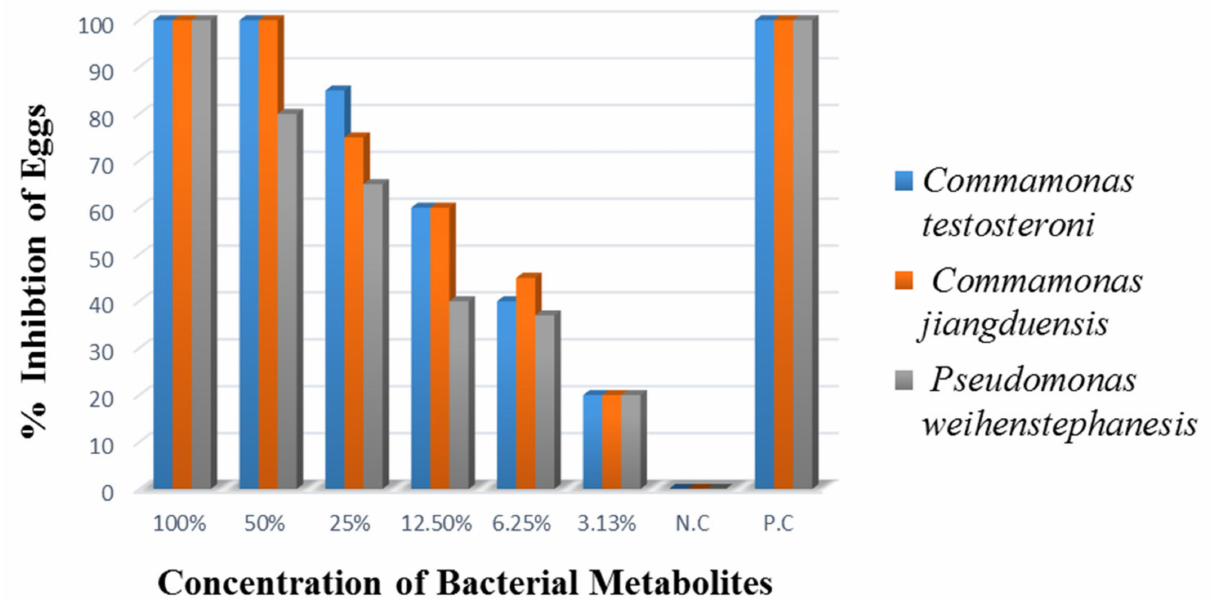
Figure 6. Percent Inhibition of eggs hatching, three days after